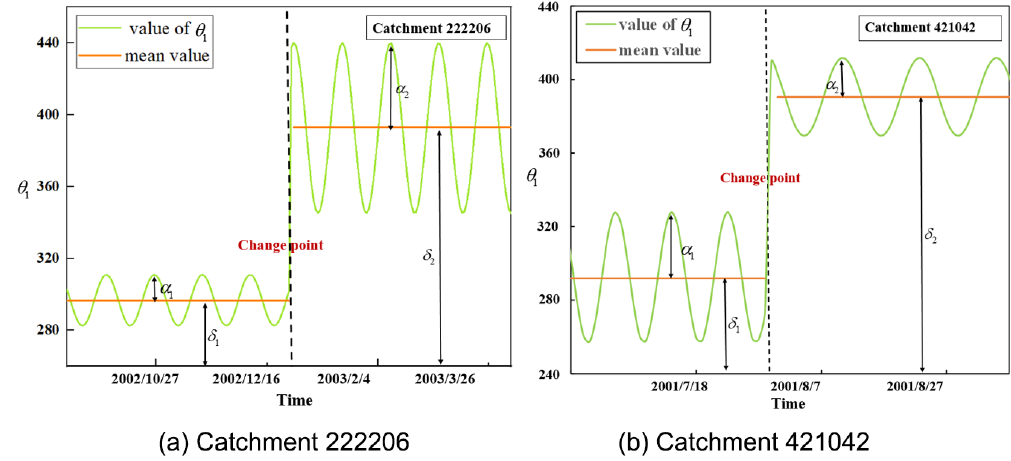
Figure 7. Time-varying patterns of model parameter θ 1 in two example catchments (i.e., catchment 222206 and 421042).